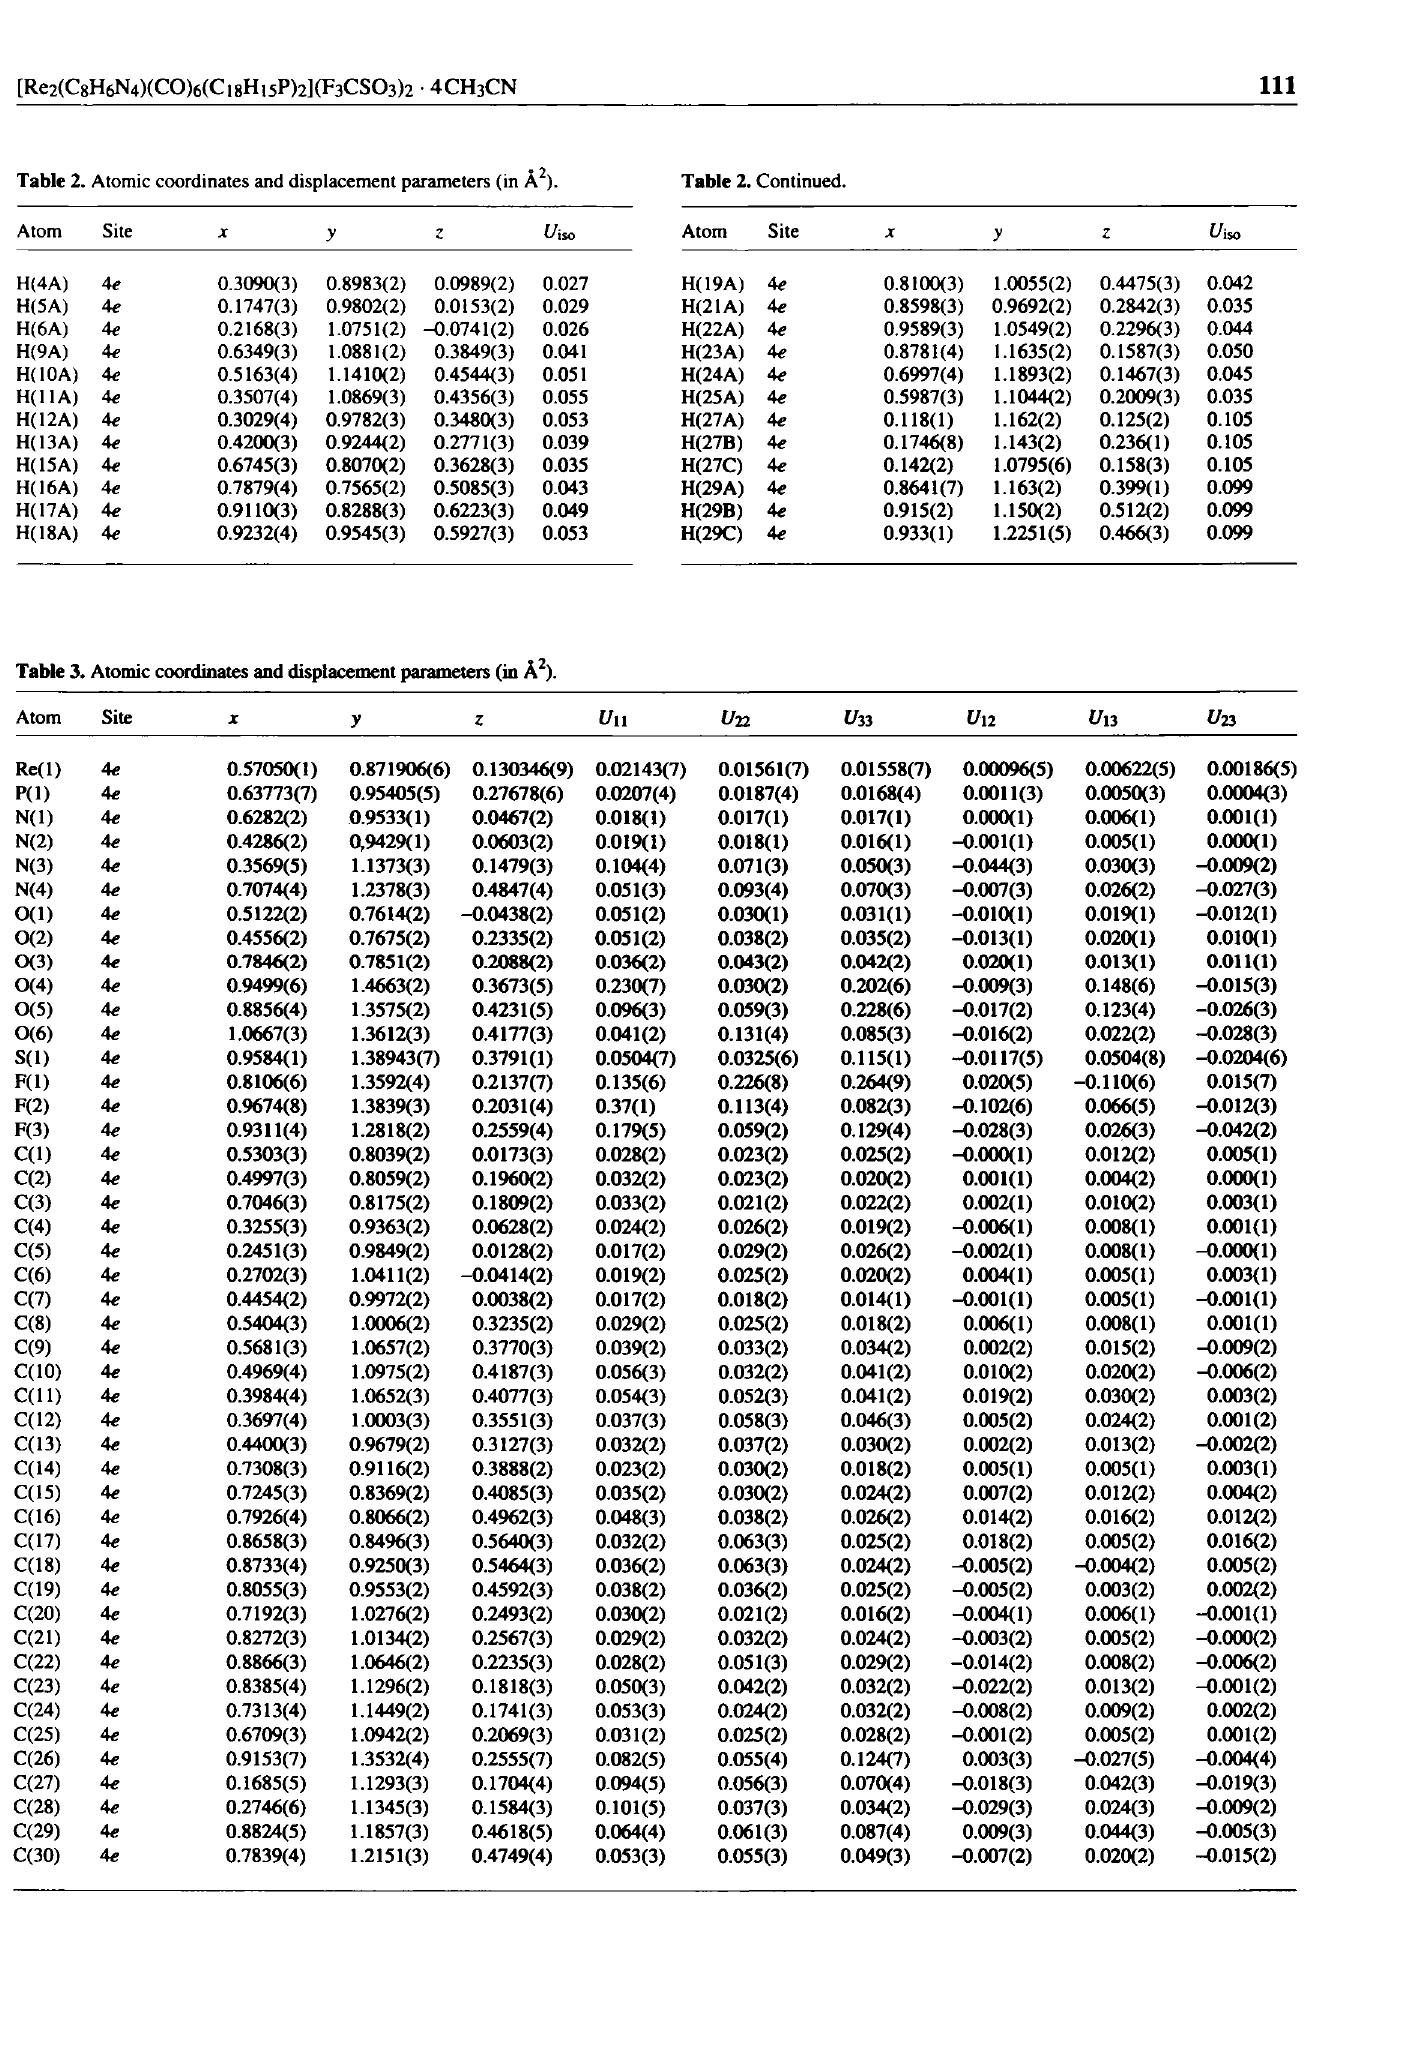
Table 3. Atomic coordinates and displacement parameters (in A 2